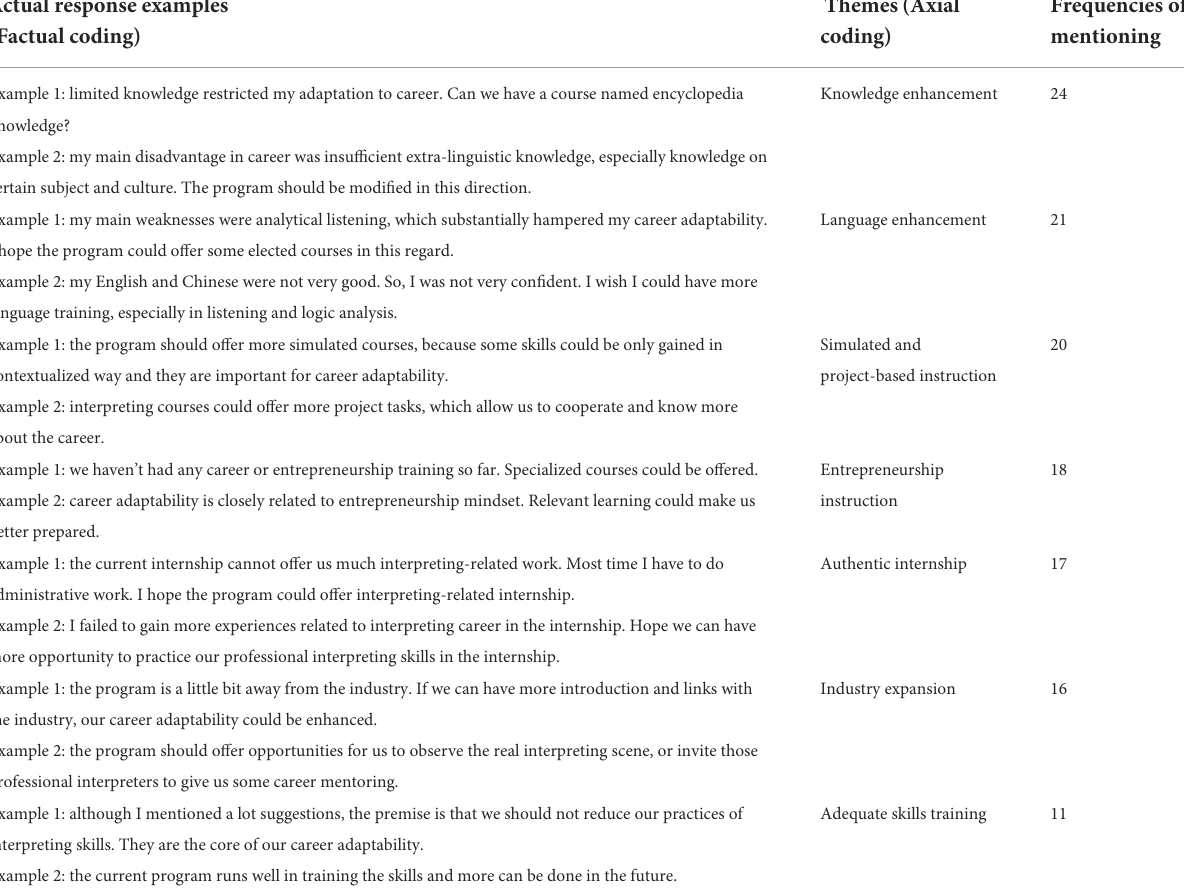
TABLE 12 Students’ suggestions for curriculum